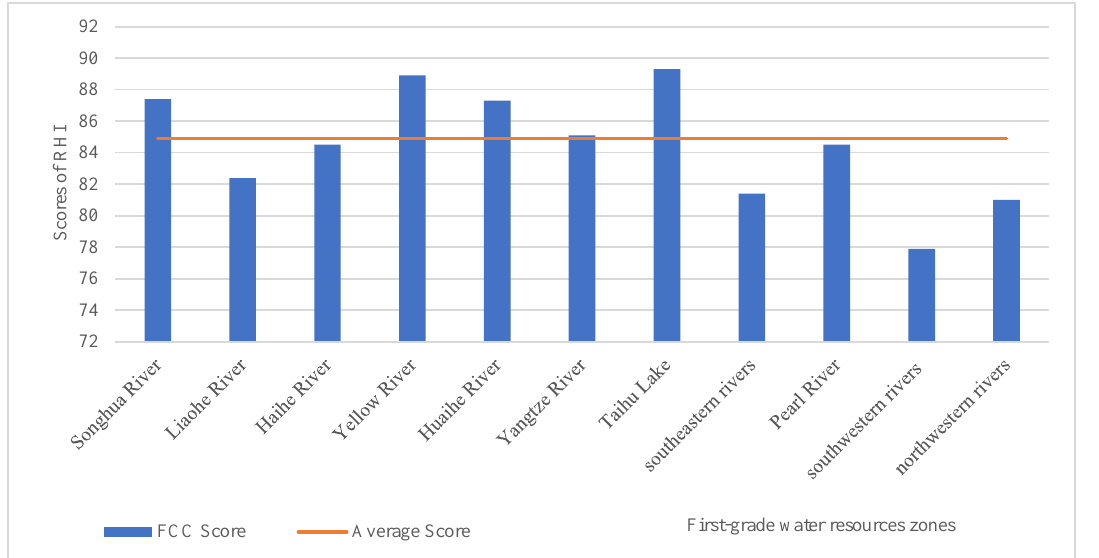
Figure 4. WRR evaluation results for China’s first -grade water resource zone